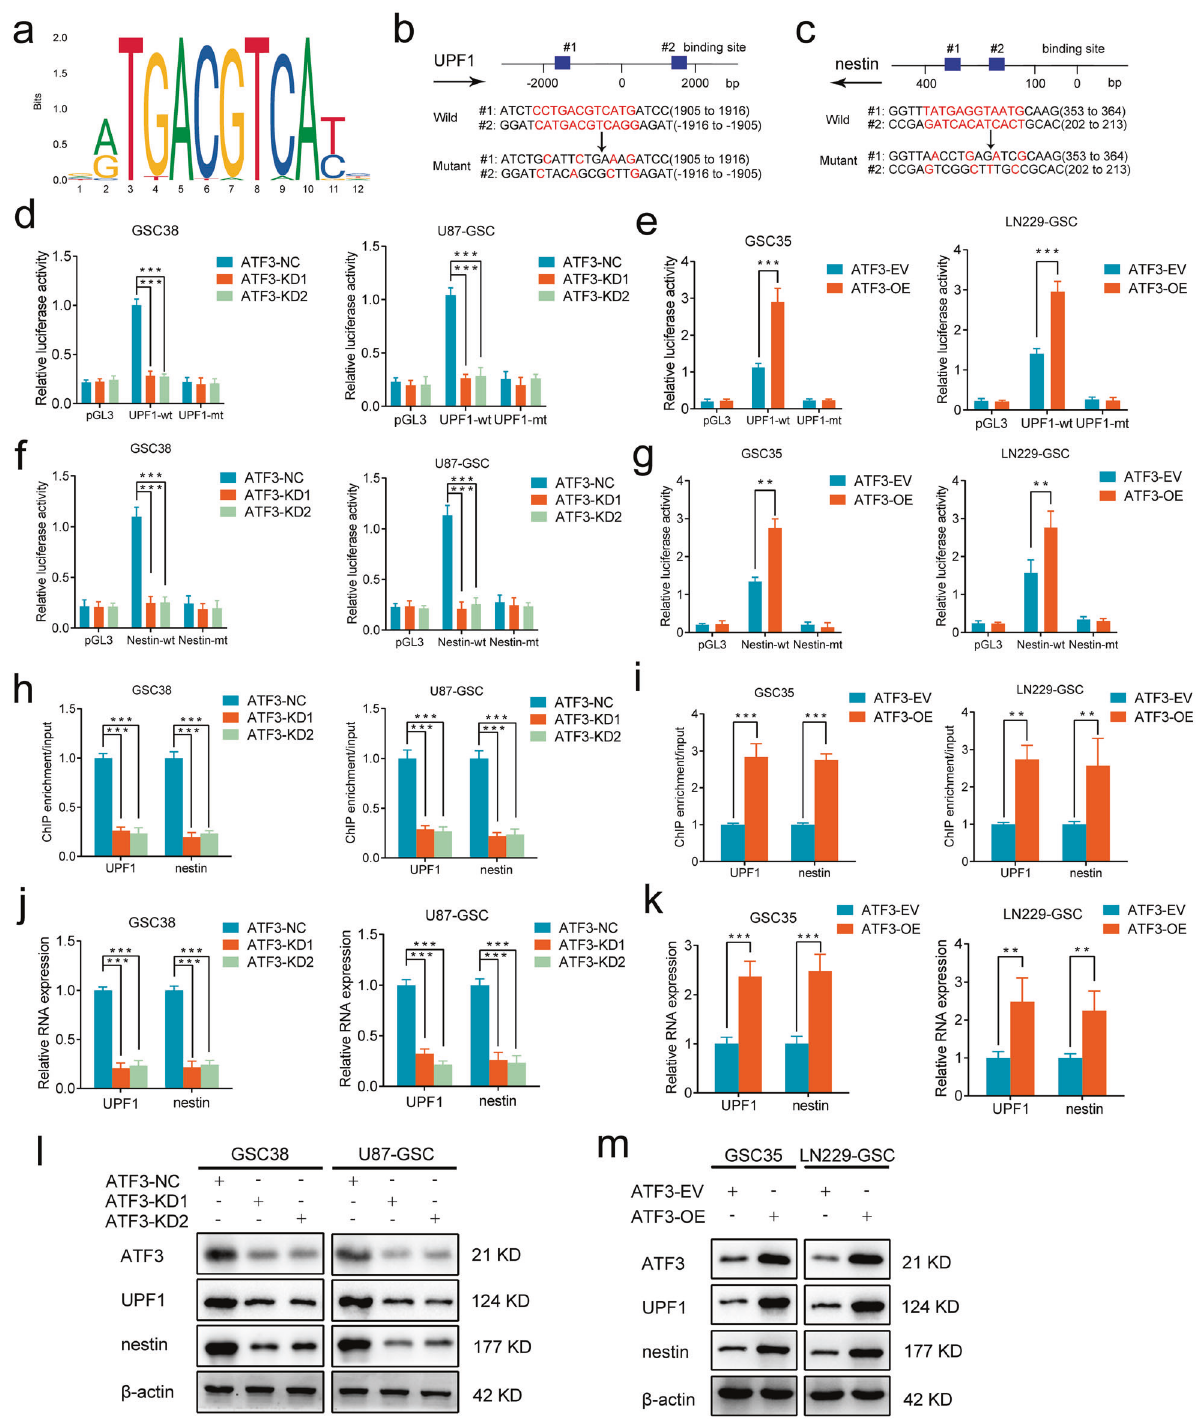
Fig. 6 ATF3 can transcriptionally promote UPF1 and nestin expression and maintain the stemness of GSCs. a Sequence motif was calculated to show the consensus ATF3 binding motif through the JASPAR database. b , c Schematic diagram of ATF3 binding site in both of the 3 ′ -UTR of UPF1 and Nestin. d-g The luciferase reporter gene assays showed that ATF3 knockdown (left) and overexpression (right) regulated the luciferase activities of UPF1 and Nestin. (GSC38, U87-GSC: p < 0.001; GSC35, LN229-GSC: p < 0.001; Student ’ s t-test). h , i ChIP qPCR assays showed a binding relationship between ATF3 and UPF1, Nestin. (GSC38, U87-GSC: p < 0.001; GSC35, LN229-GSC: p < 0.01; Student ’ s t-test). j , k QPCR showed that the RNA expression of UPF1 and Nestin was reduced by ATF3-KD and was increased by ATF3-OE. (GSC38, U87-GSC: p < 0.001; GSC35: p < 0.001; LN229-GSC: p < 0.01; Student ’ s t -test). l , m Western blotting revealed that ATF3-KD downregulated the expression of UPF1 and Nestin, while ATF3-OE upregulated the expression of UPF1 and Nestin. (GSC38, U87-GSC: p < 0.001; GSC35: p < 0.001; LN229-GSC: p < 0.01; Student ’ s t-test) EV: empty vector, OE: overexpression, NC: negative control, KD: knockdown. All results are obtained as the mean ± SD under at least biological triplicate assays. * p < 0.05, ** p < 0.01, *** p < 0.001.